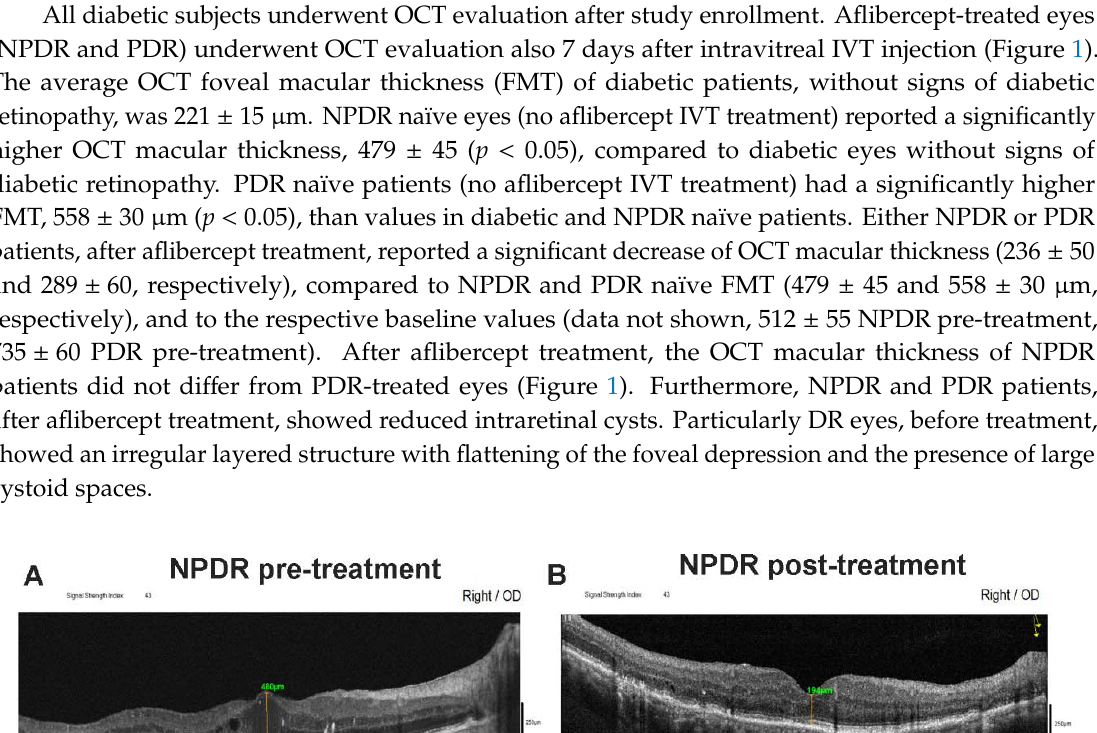
Figure 1. Representative optical coherence tomography (OCT) images of macular thickness . Aflibercept treatment decreased significantly ( p < 0.05) foveal macular thickness in non ‐ proliferative diabetic retinopathy (NPDR) and proliferative diabetic retinopathy (PDR) patients, compared to untreated naïve groups. Foveal macular thickness measurement in enrolled subjects beloging to the followig groups: NPDR before ( A ) and after ( B ) aflibercept treatment, PDR before ( C ) and after ( D ) aflibercept treatment, and OCT evaluation in diabetic patients without DR ( E ). Mean foveal macular thickness ( F ) μ m ± S.D.; * p < 0.05 vs. diabetic; † p < 0.05 vs. NPDR naïve; ‡ vs. PDR naïve patients. 2.3. Serum Growth Factor Levels Levels of pro ‐ angiogenic factors VEGF ‐ A and PlGF have been evaluated in the serum of the study subjects. VEGF ‐ A serum levels (Figure 2) in diabetic patients, naïve NPDR and PDR subjects, were significantly higher than the levels detected in the serum of age ‐ matched control subjects. The VEGF ‐ A serum levels of NPDR and PDR patients, one week after intravitreal treatment with aflibercept, were significantly decreased when compared to diabetic, naïve NPDR and PDR patients.